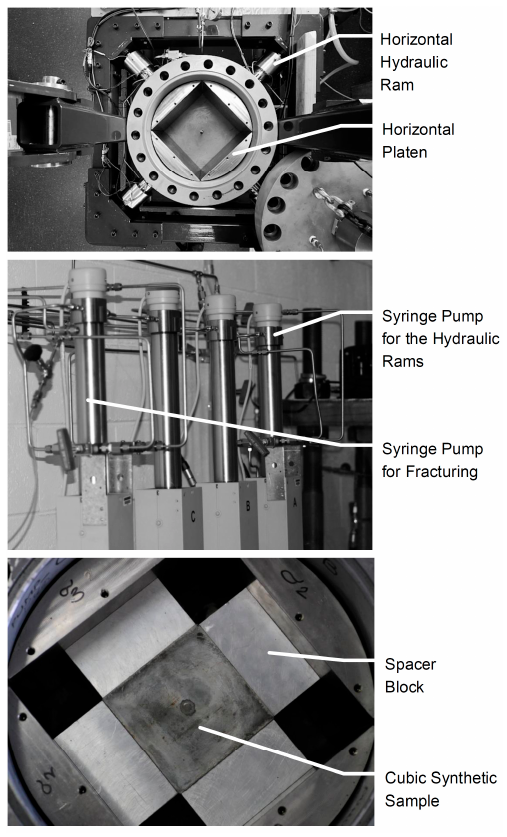
Figure 3. A view of the TTSC with the horizontal platen and the horizontal hydraulic rams ( top ), syringe pumps for the hydraulic rams and fracturing fluid injection ( Middle ), and a synthetic sample accommodated in the TTSC using the spacer blocks ( Bottom ).